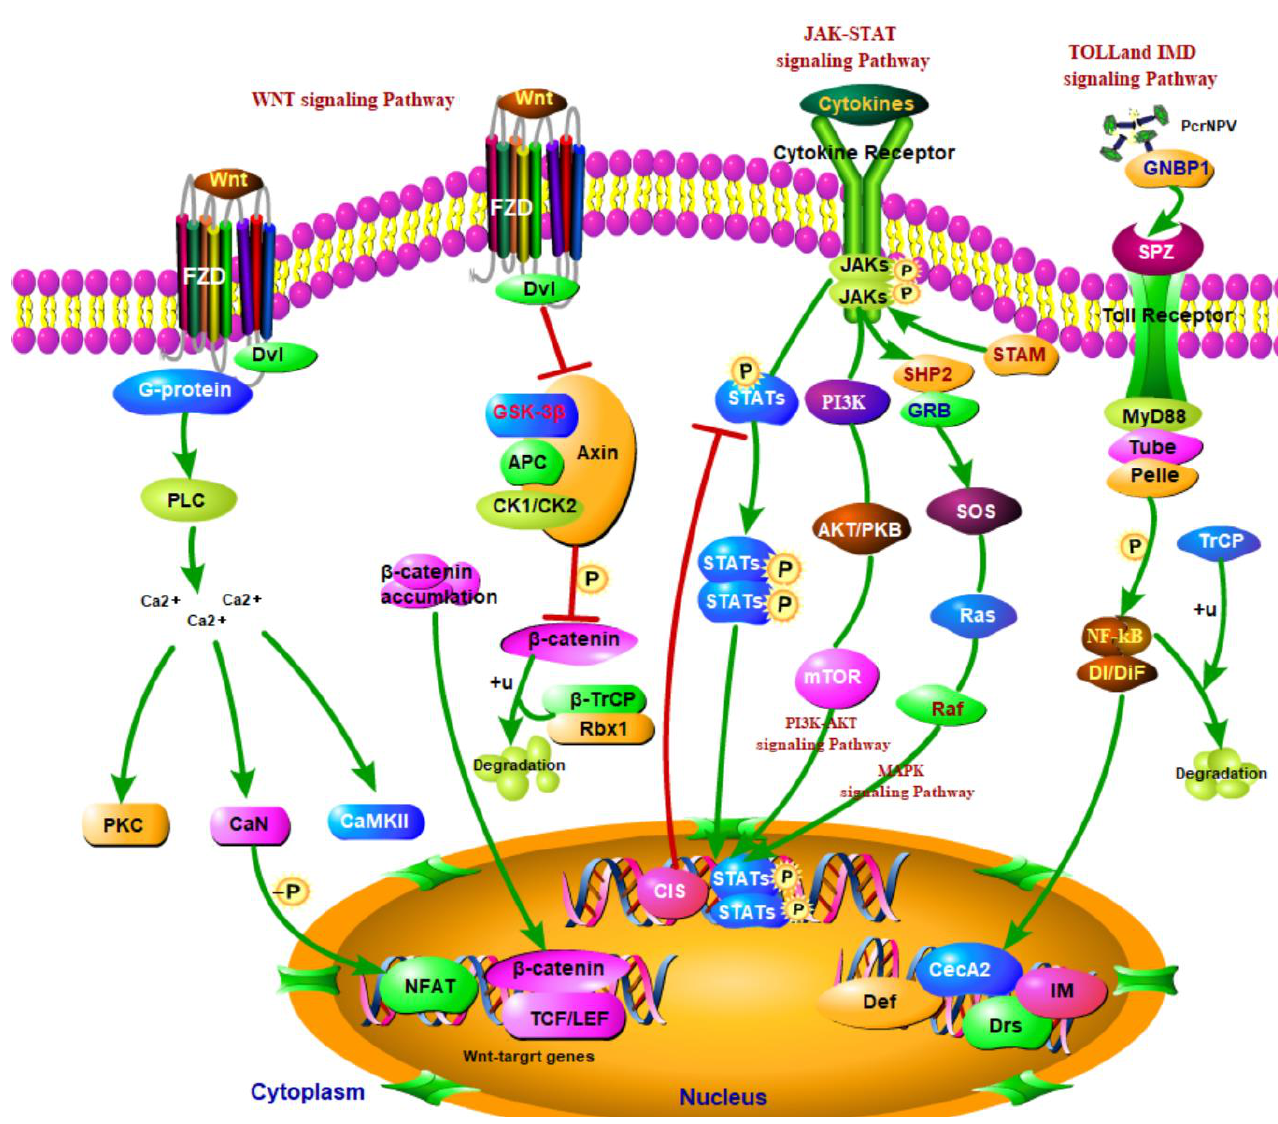
Figure 9. Immune pathways involved in S. ricini after SariNPV infection.